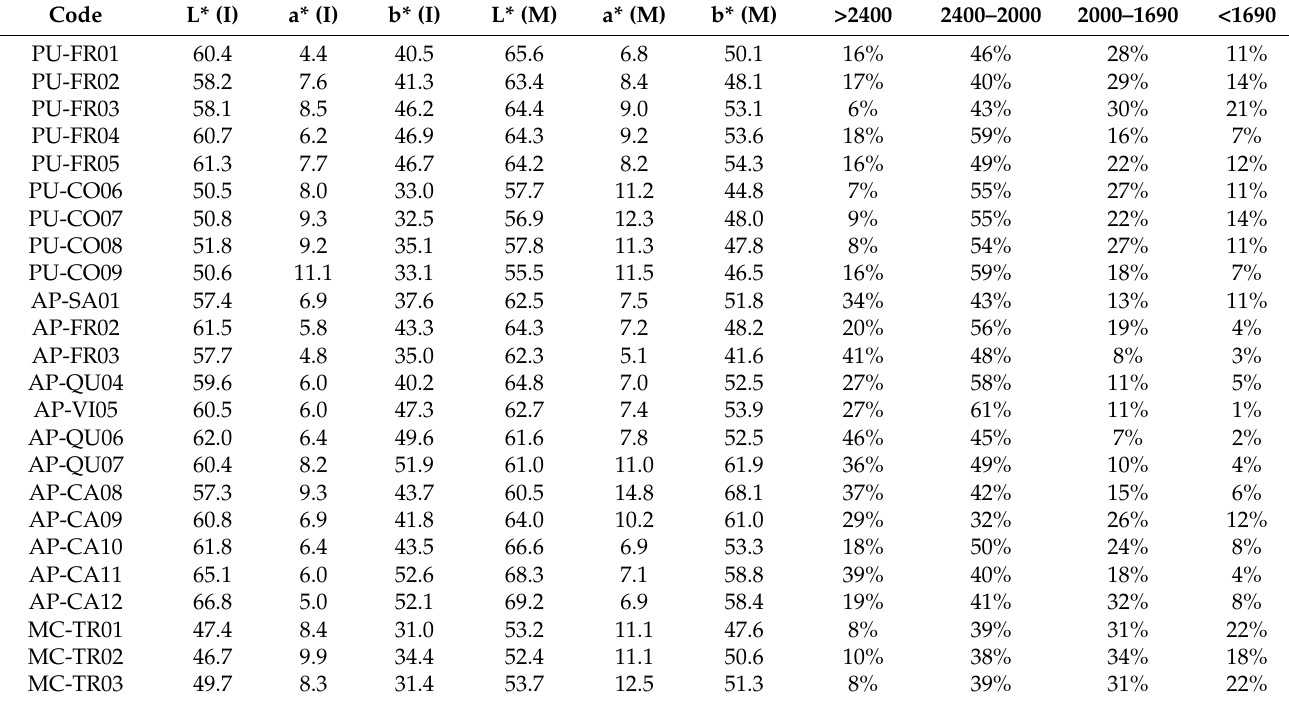
Table 3. Instrumental colour data (CIE L*a*b* colour space coordinates) of the surface of integer (I) and finely milled (M) loads and pollen load size